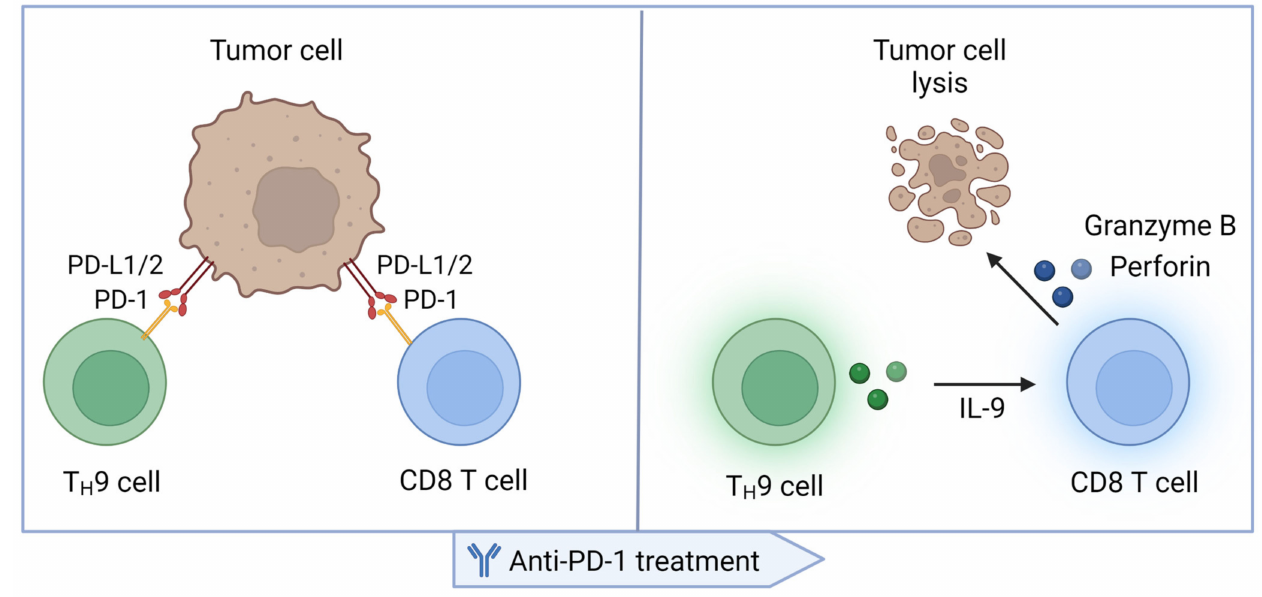
Figure 1. The proposed role of IL-9 in the response to anti-PD-1 therapy. IL-9 production in TILs is regulated by PD-1 signaling [26,34]. Anti-PD-1 antibody stimulates IL-9 production in TILs which enhances the cytotoxic properties of tumor-reactive CD8 T cells. This model is supported by observations in cancer patients: CD8 TILs of patients with high IL-9 + cell infiltration respond to nivolumab treatment by expanding and producing effector molecules